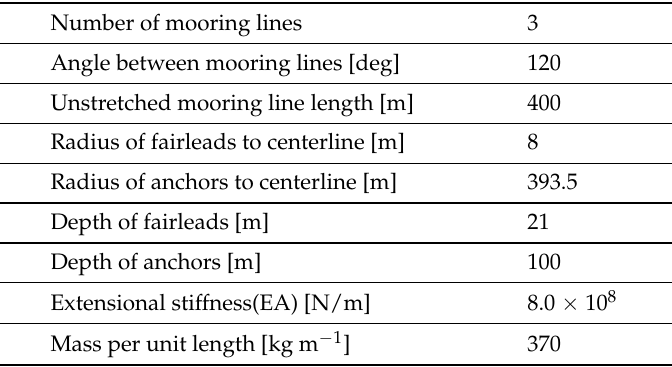
Table 2. Main properties of the mooring lines.